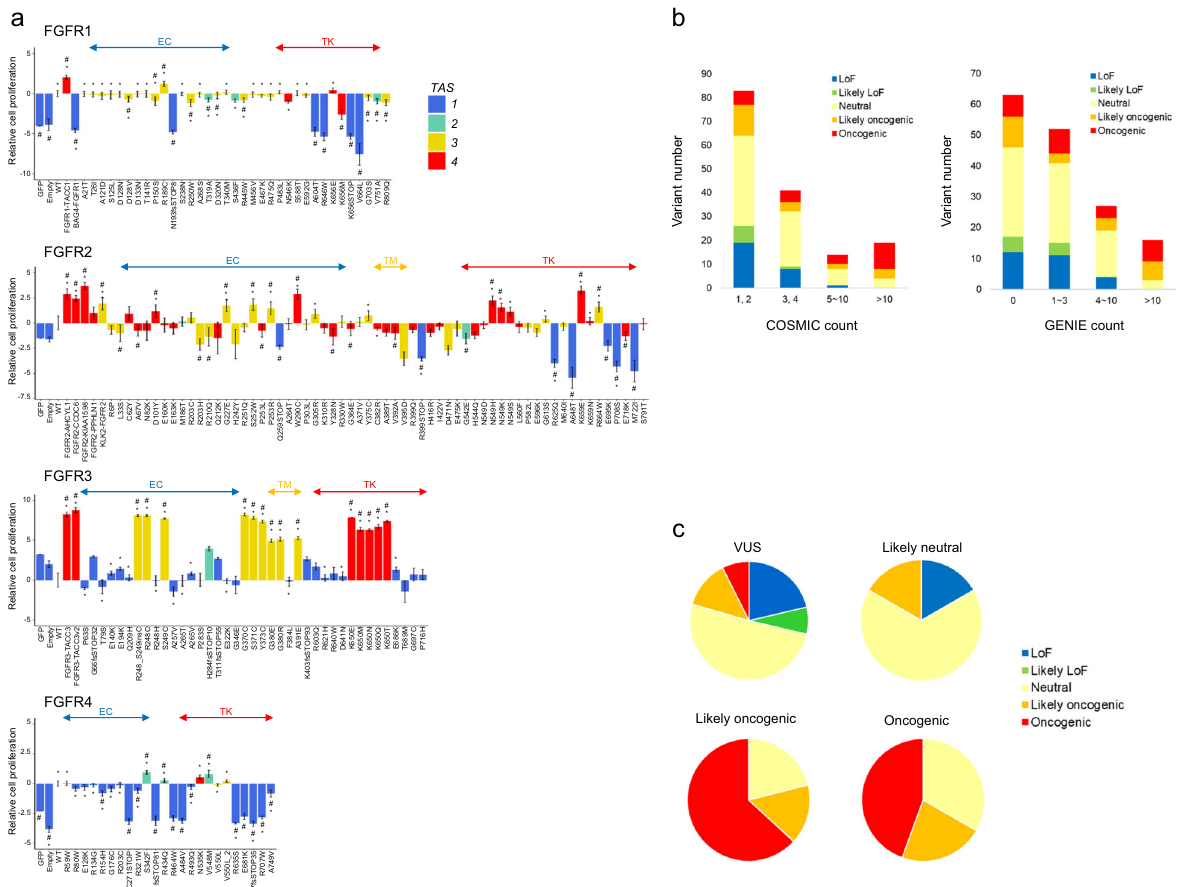
Fig. 2 Transforming activity of FGFR variants. a Fold changes from day 3 to day 18 of 3T3 cells harboring each FGFR variant in the mixed cell population were calculated using the MANO method and shown as relative proliferation to wild-type on a base 2 logarithmic scale. Relative proliferation signi fi cantly different from those of wild-type (#) or GFP (*) are shown (paired t -test, p < 0.05). The color of each bar indicates the TAS, which are integrated assessments based on the results of the focus formation assay and low-serum cell proliferation assay. The bars are sorted according to the position of amino acids. b The results of the focus formation assay and growth competition assay by the MANO method were summarized to annotate the oncogenicity of variants according to the classi fi cation described in the method. The oncogenicity evaluated by the method is shown in colors and compared with the variant count number of COSMIC or AACR Project GENIE. c The oncogenicity evaluated by the method is shown in colors and compared with that of OncoKB. The OncoKB annotations are shown at the